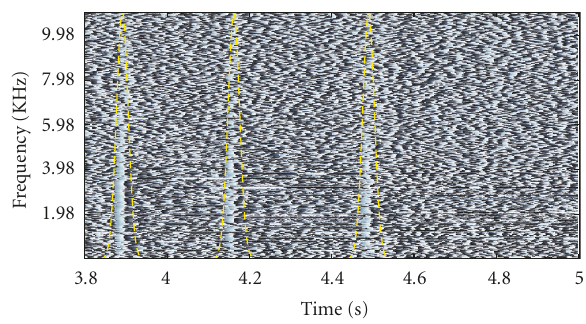
Figure 8: The phase plane of the STFT of Figure 4 transformed ac- cording to (6). The dashed line represents the labeled onsets posi- tions.